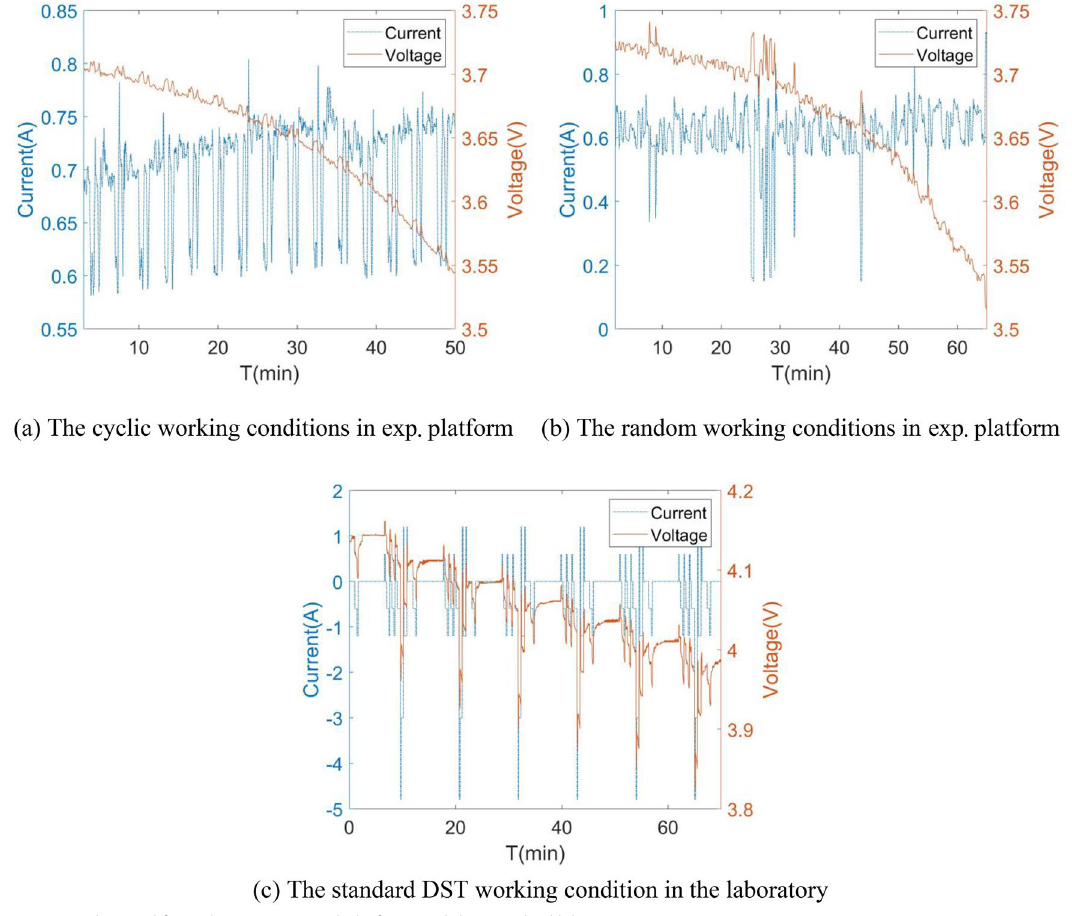
Figure 11 Data obtained from the experimental platform and the standard